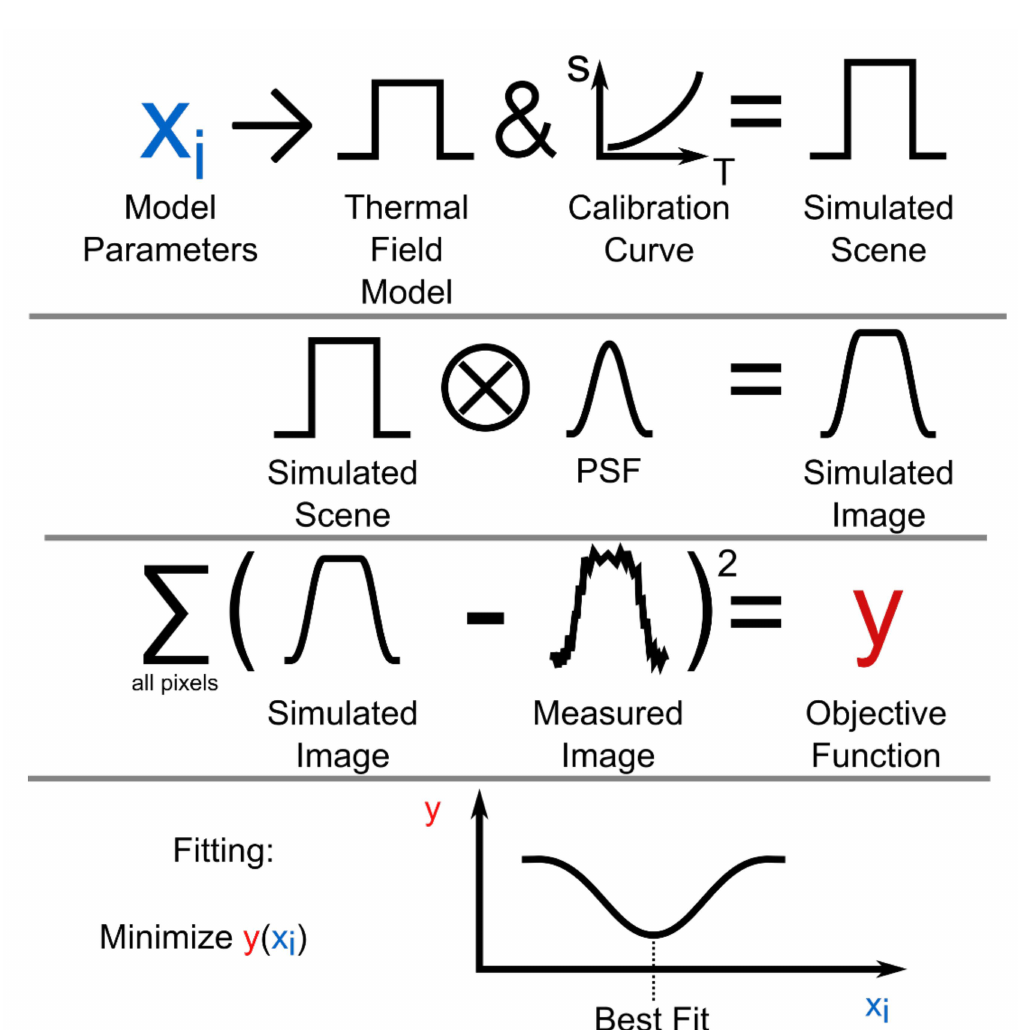
Figure 5. Workflow for application of thermal field reconstruction technique. The Point Spread Function (PSF) is a representation of the spatial transfer function of the thermographic